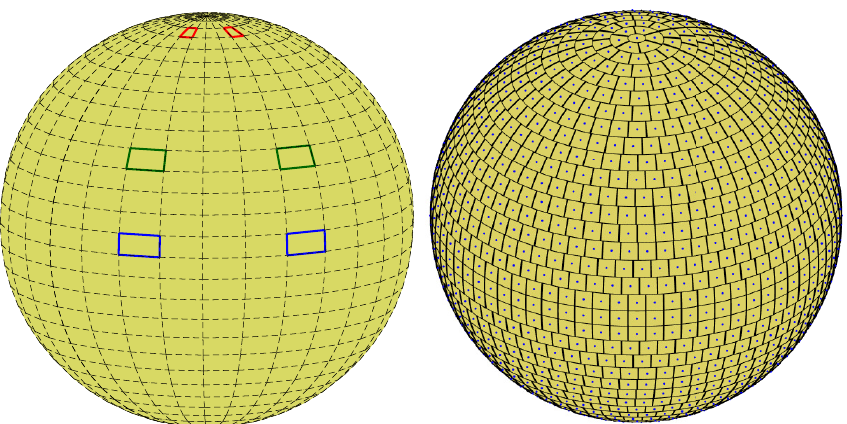
Figure 7. ( Left ) Uniform rectangular quantization of the parameter plane, i.e., uniform quantization of the angular coordinates θ and ϕ , corresponds to cells of non-uniform area on the sphere. Cells are small near the poles and large near the equator. ( Right ) Almost-equal-sized cell